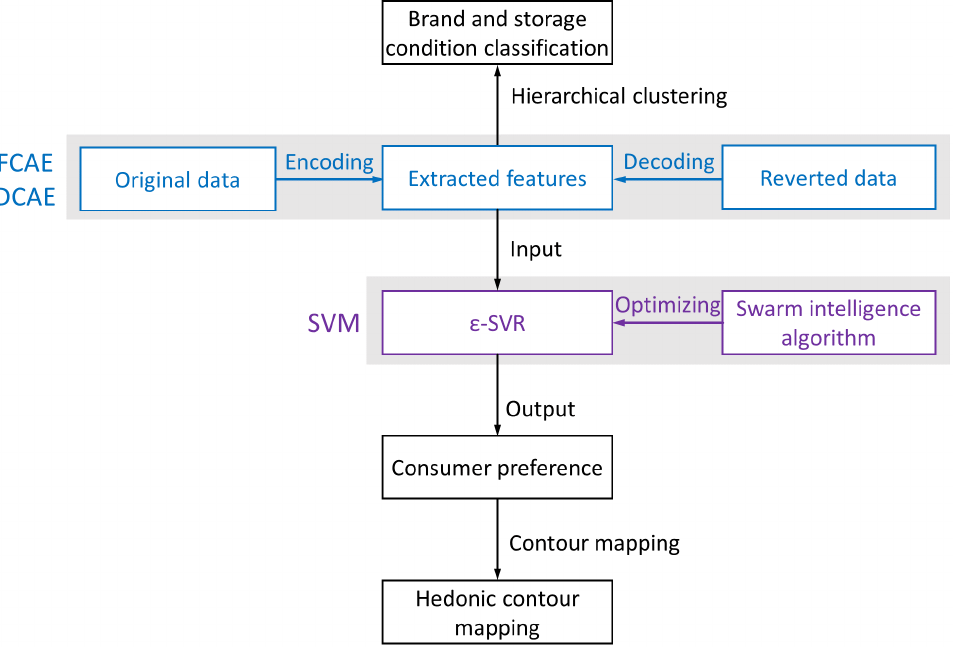
Figure 3. The overall deep learning process for yogurt sensory and preference analysis.